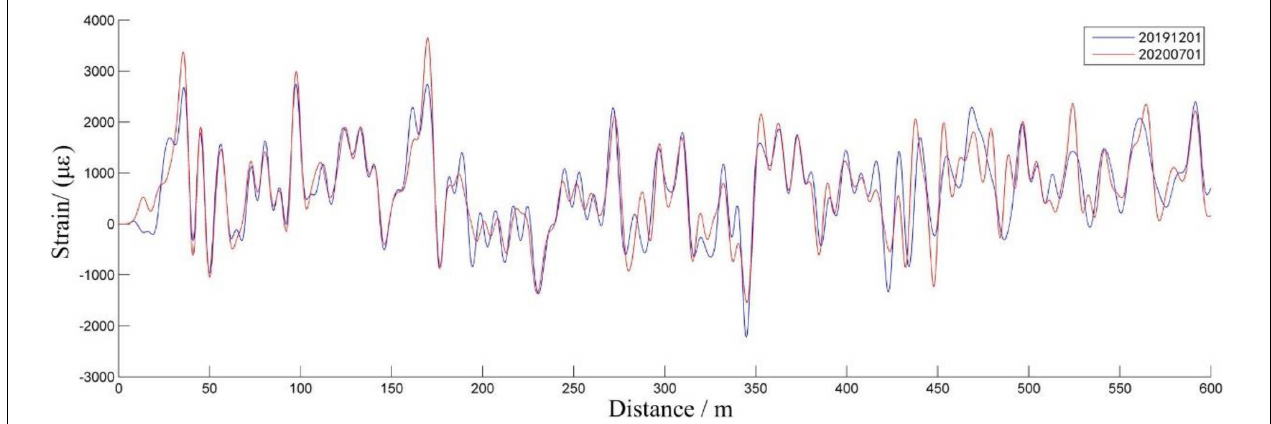
FIGURE 7 | The initial monitoring data of the NBX-6050